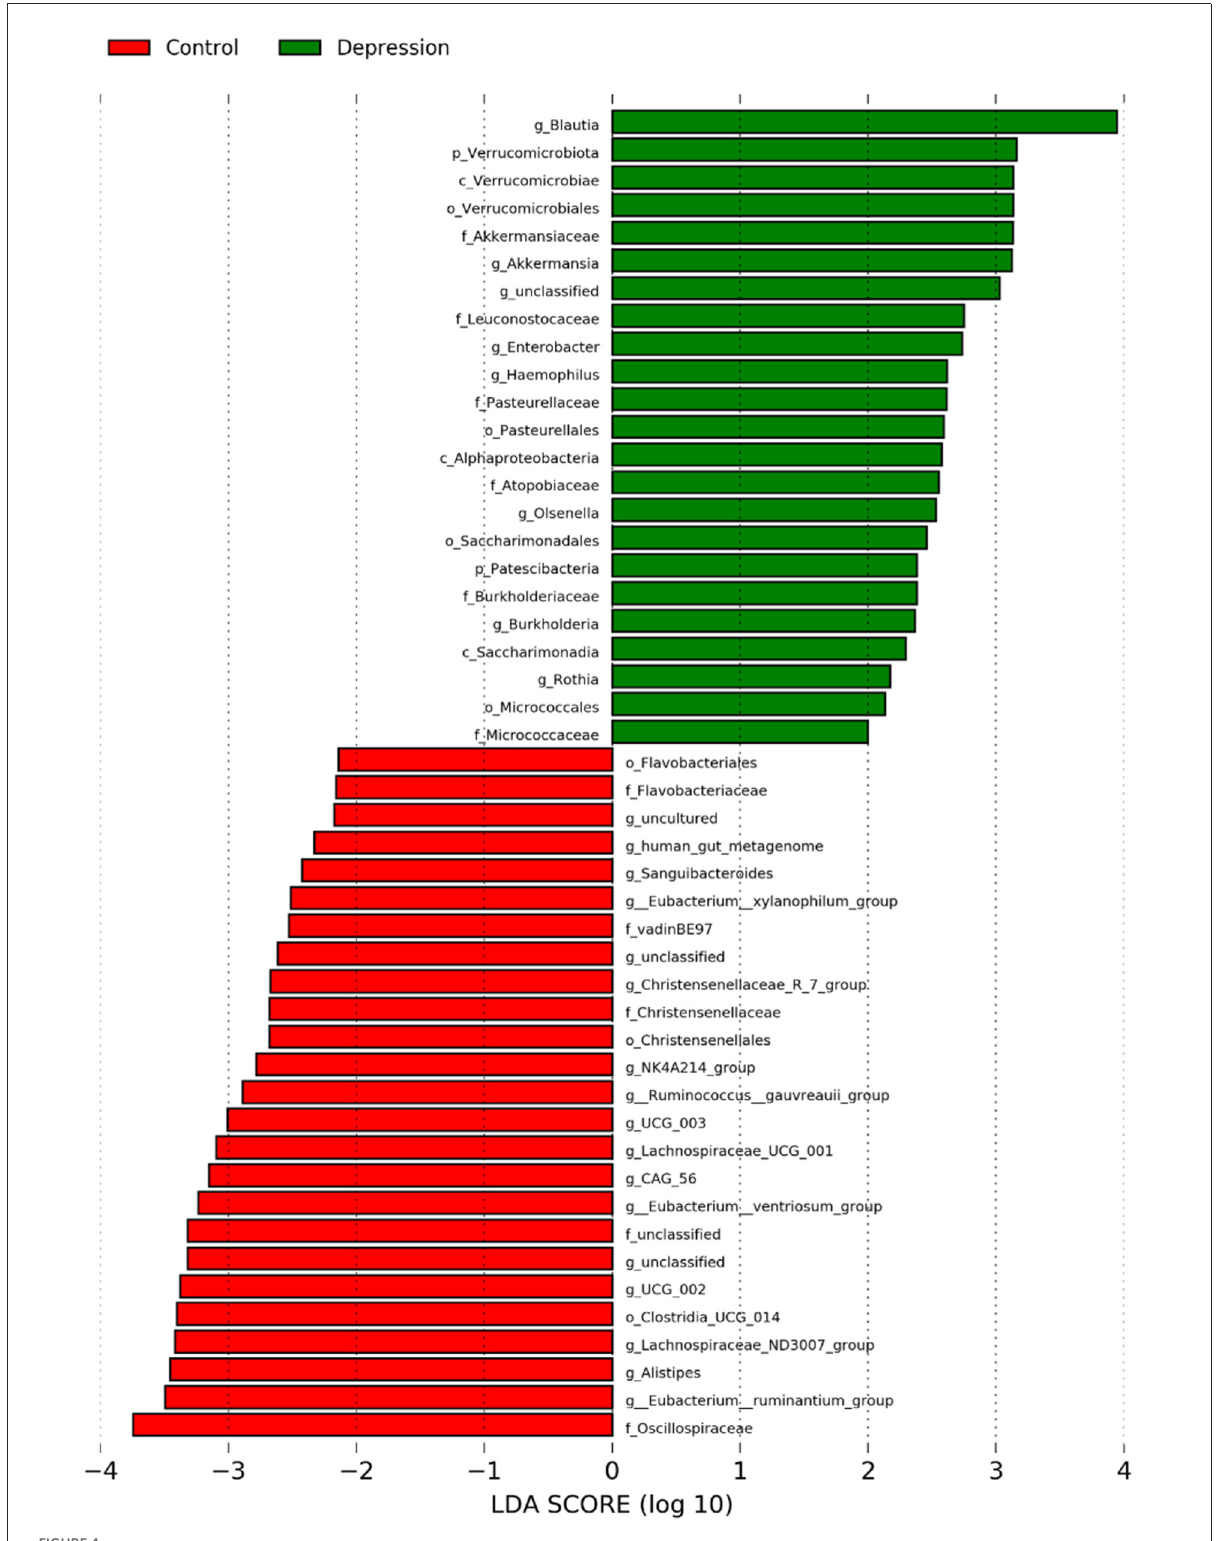
FIGURE4 Abundances of bacterial taxa at the genus level in the late-life depression (LLD) patient and healthy control groups, as determined with the linear discriminant analysis (LDA) effect size (LEfSe) method. The taxonomic cladogram was generated based on the LEfSe and LDA scores. LLD-enriched taxa are indicated with a positive LDA score (green), and taxa enriched in controls have a negative score (red). Only taxa meeting the LDA significance threshold > 2 are